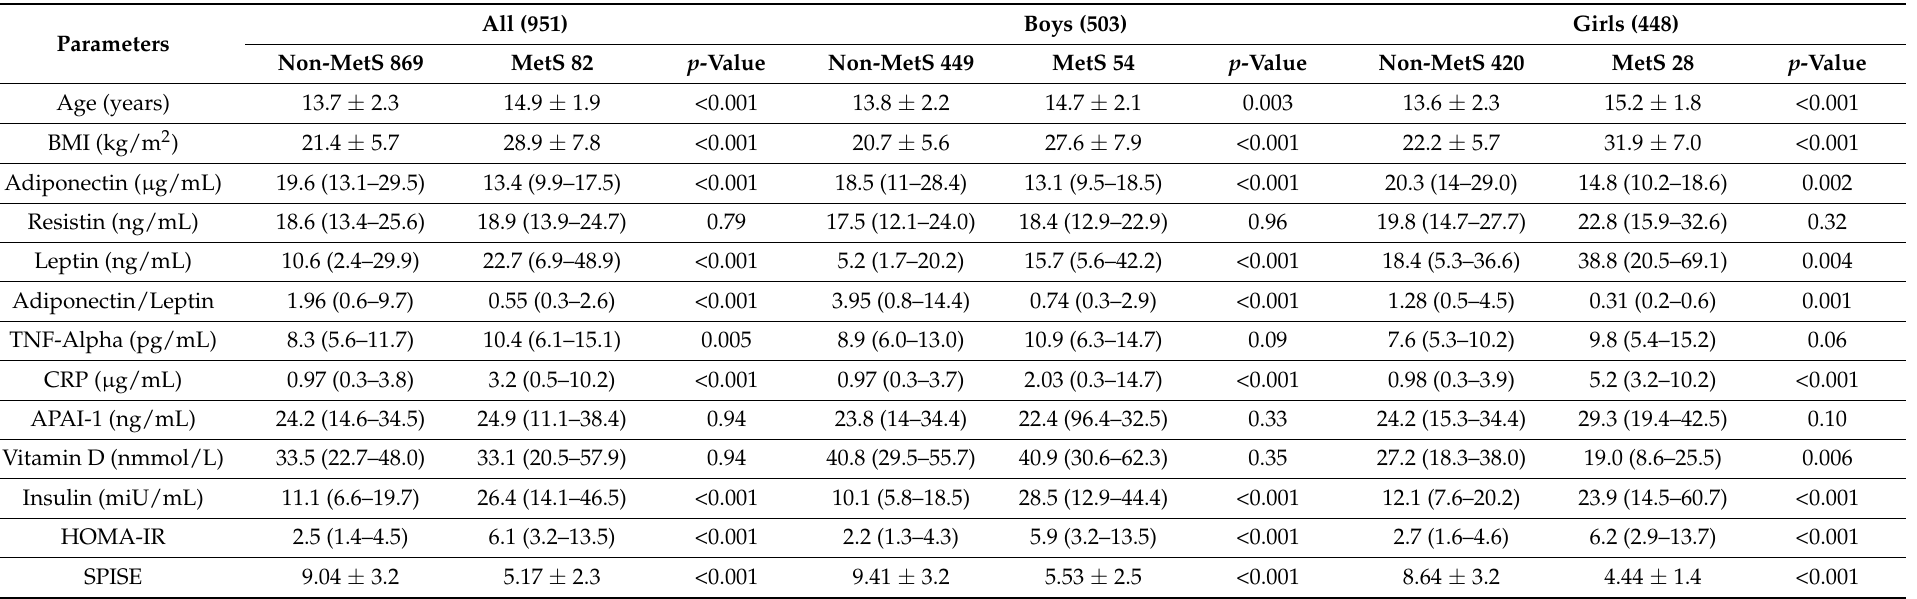
Table 2. Clinical Characteristics of Participants according to MetS